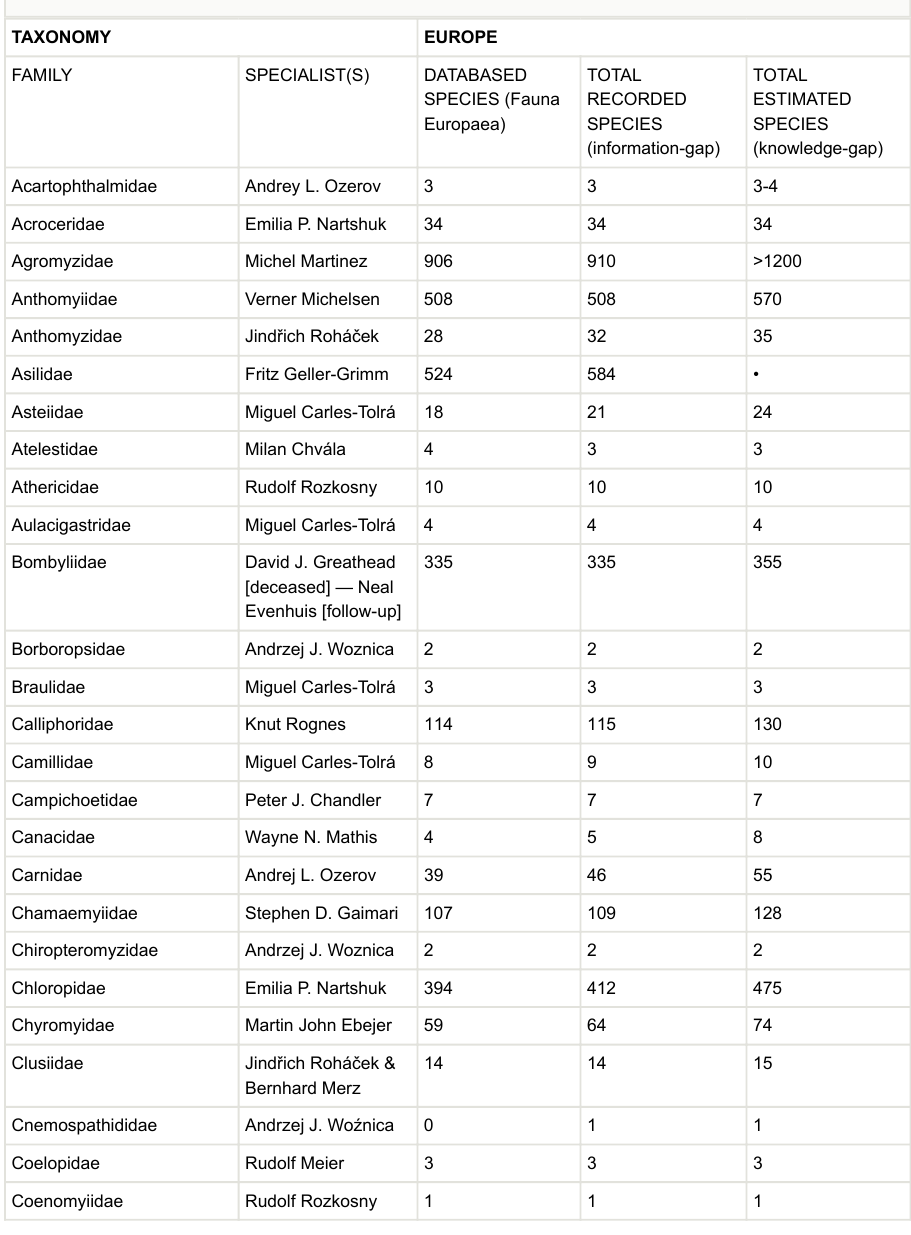
Table 1. Taxonomic specialists per family for Diptera–Brachycera and their responsibilities. Expert replacements to be implemented for coming versions are given in Table 2. The actual numbers of databased species are given per family. For most families is also given an indication of the actual number of known/described species (showing a potential information gap) plus an estimate of the total number of existing species (i.e., described/known plus undescribed/undiscovered) for